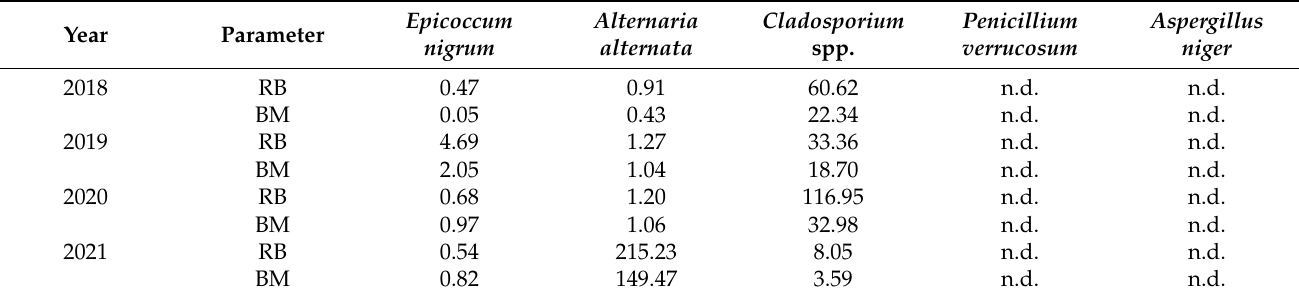
Table 4. Cumulative fungal DNA contents (pg fungal DNA per ng barley DNA) per harvest year (2018–2021) in raw barley (RB) and barley malt (BM); analyzed by quantitative real-time PCR; n.d. = not